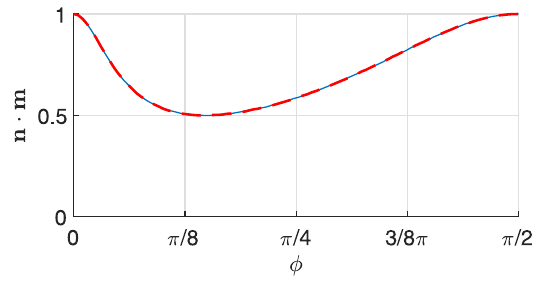
Figure 9. Dependence of n · m on φ for uniaxial